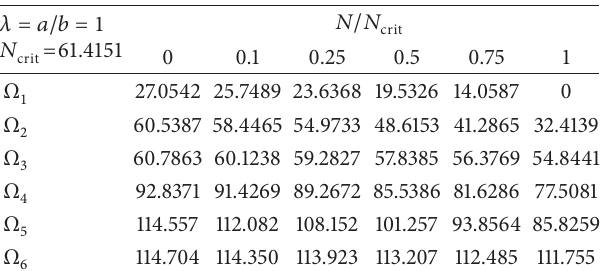
Table 2: The first six natural frequency coefficients Ω 𝑖 for a C-C-SS- SS plate under uniform 𝑁 𝑥 loading ( 𝛼 = 0